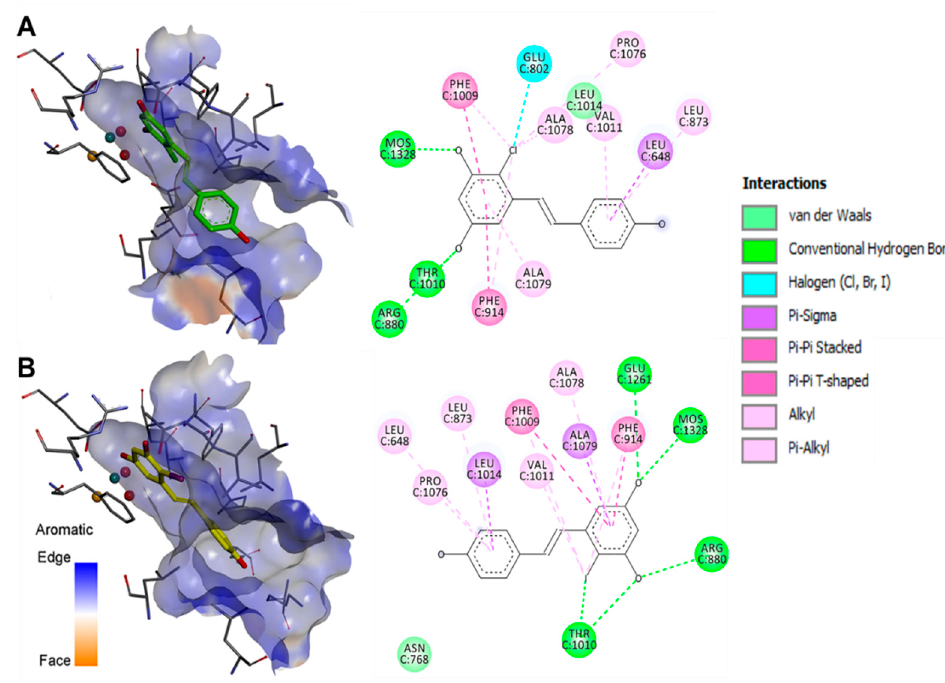
Figure 2. Best-docked poses of compounds 2 ( A ) and 4 ( B ). Three-dimensional orientation and aromatic edge/face receptor surface is shown for both compounds at identical viewing angle and zoom ( left ), along with the 2D interpretation of the ligand–residue interactions with the 3NVY protein ( right ).